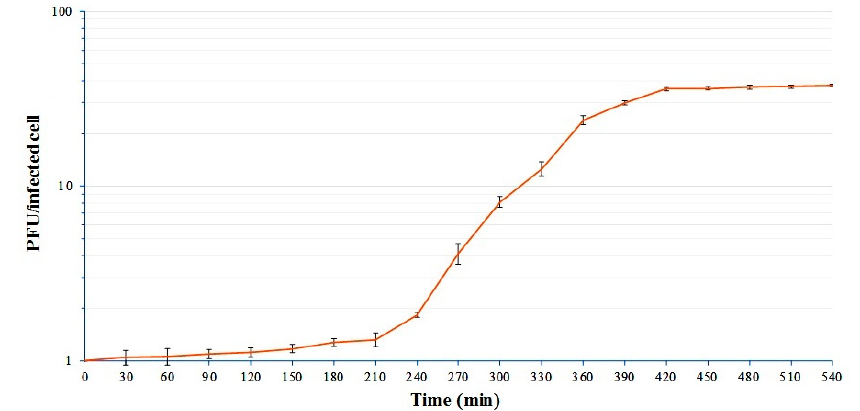
Figure 2. One-step growth curve of the vB_StuS_MMDA13 phage. Ratios between PFU and the number of infected bacterial cells at different time points are shown. Data are the mean of three independent experiments. Vertical black bars represent one standard deviation.